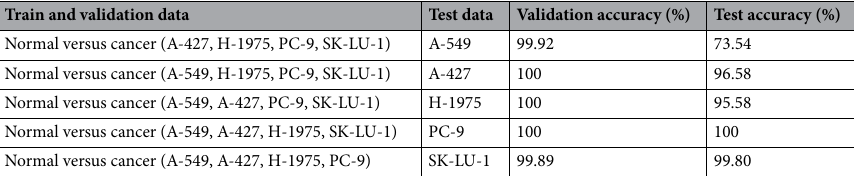
Table 5. Classification accuracies of the ResNet18 architecture (normal vs. cancer) for unseen test